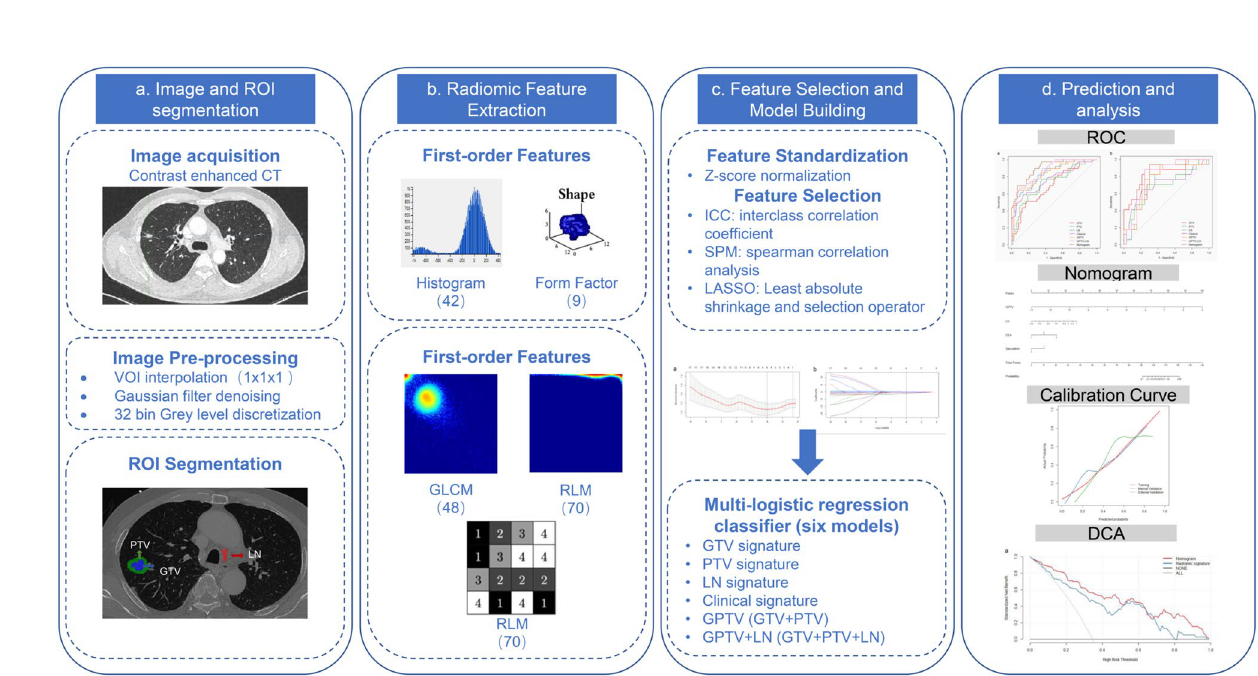
Figure 2. Work flow of tumor segmentation, feature extraction and signature building. Region of interest (ROI) was manually placed on axial CT over gross tumor volume (GTV) (in blue), and lymph nodes (LN) (in red). GTV was dilated 5 mm in all three dimensions uniformly to capture the peritumoral volume (PTV) (green).